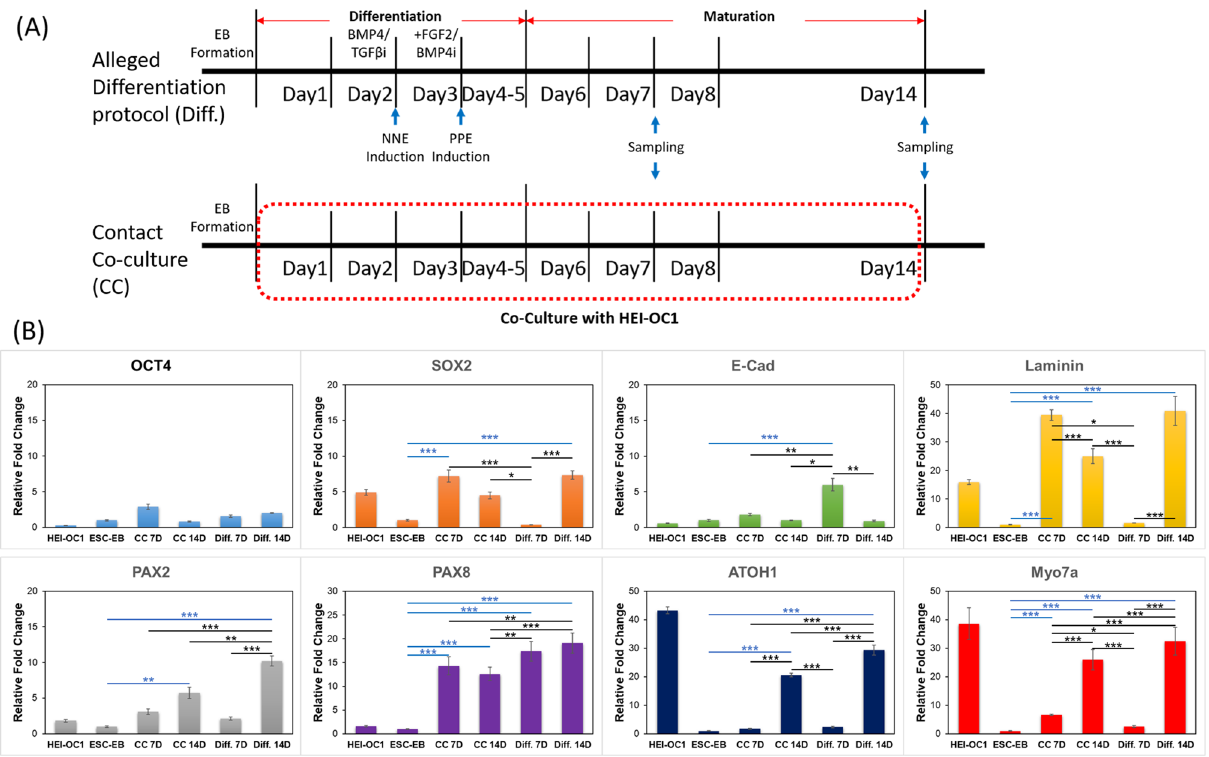
Figure 6. RT-PCR analysis of co-cultured EBs. ( A ) Two different processes of differentiation. The top image shows the differentiation (Diff) protocol for otic organoids and, the bottom image shows the protocol for contact co-culture (CC). ( B ) In both differentiation protocols, EBs are harvested at 7 and 14 days after initiation of differentiation. ( B ) Oct4 was not detected in HEI-OC1 cells. SOX2 was detected in all stem cells